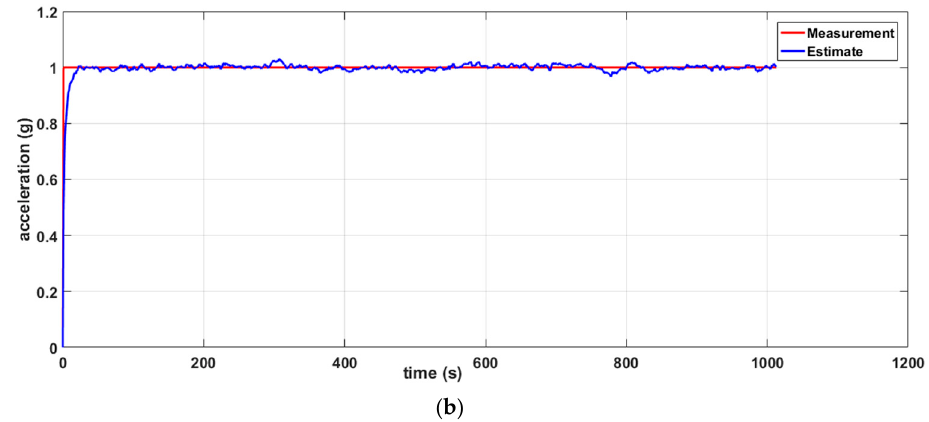
Figure 10. Results for distributed Kalman filter implementation with noisy measurements from a single sensor node. ( a ) Sensor node S1. ( b ) Sensor node S2.